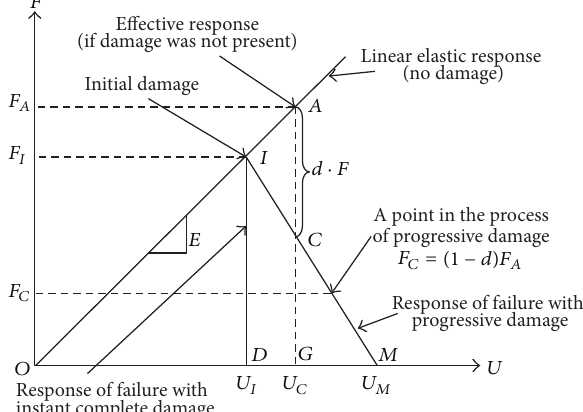
Figure 8: Damage evolution law for the bolt behavior. Note: 𝑈 𝐼 , 𝑈 𝐶 , and 𝑈 𝑀 are displacement values of points 𝐼 , 𝐶 , and 𝑀 , respectively; 𝐹 𝐼 , 𝐹 𝐼 , 𝐶 , and 𝐴 , respectively, where 𝐹 𝐹 𝐶 , and 𝐴 are forces of points damage variable of the connector